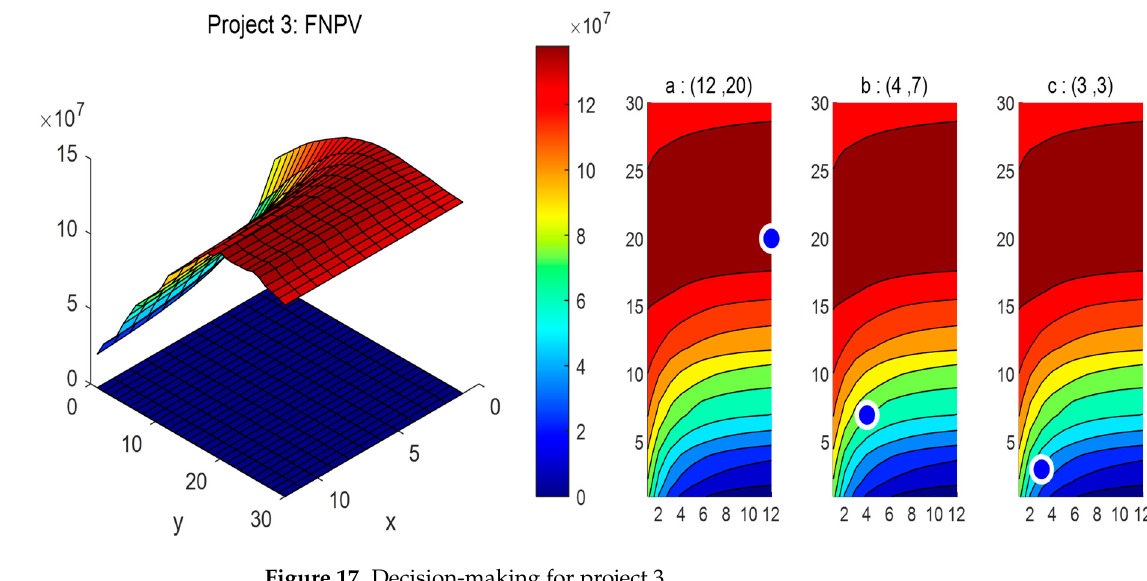
Figure 17. Decision − making for project 3. Figure 17. Decision-making for project 3.